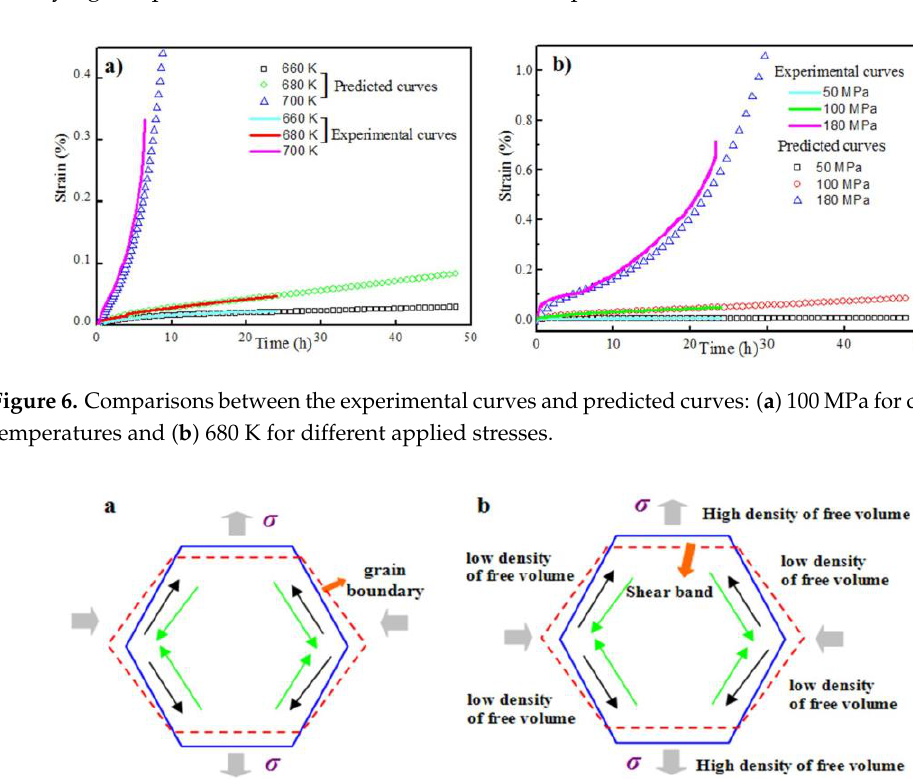
Figure 7. Schematic diagram of ( a ) Nabarro-Herring creep model (black arrows: atom diffusion; green arrows: vacancy diffusion) [38], and ( b ) creep model for bulk metallic glass (BMGs) (black arrows: atom diffusion; green arrows: free volume movement).